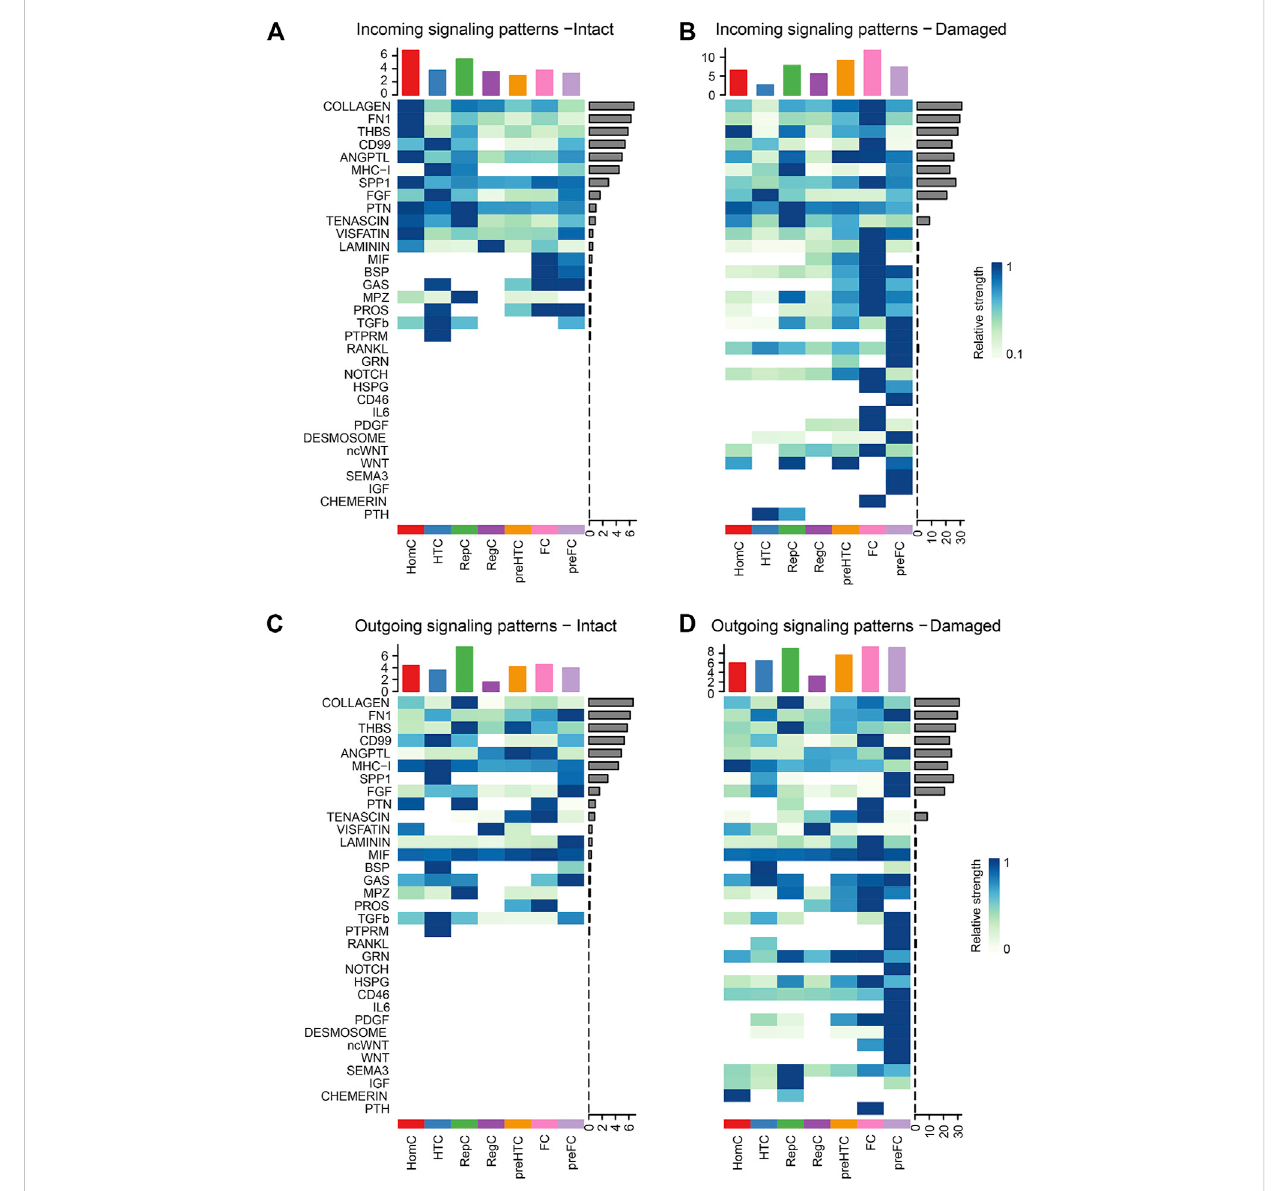
FIGURE 6 Heatmapsoftheincoming (A – B) andoutgoing (C – D) signalingpatternineachcellsubtypemediatedbyindividualsignalingaxesbetweentheintact and damaged cartilage samples. Cell types are distributing on the horizontal axis and signaling pathway on the vertical axis. The upper and right columns are the relative strength of the vertical and horizontal axes, respectively.